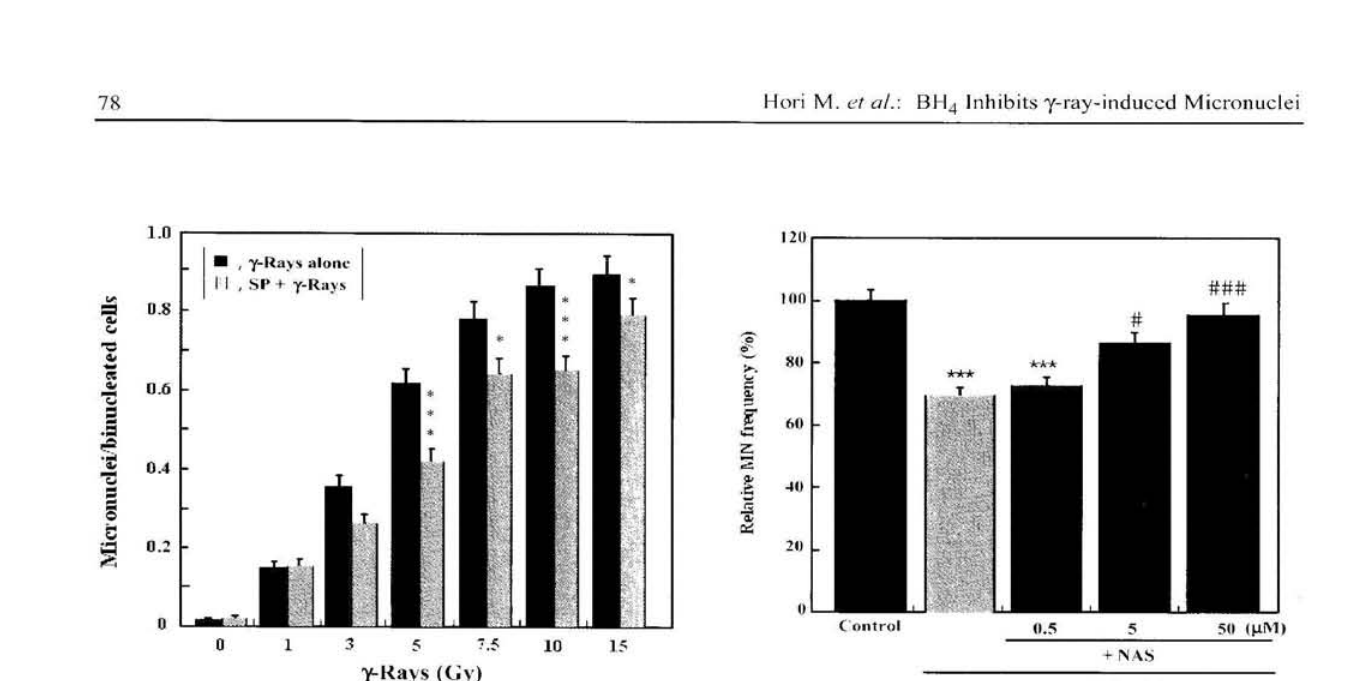
Figure 4. Micronucleus (MN) frequency induced by various doses of γ-rays at 18 h after treatment with 1 mM sepiapterin (SP) in RAW264.7 cells. RAW264.7 cells were incubated with 1 mM sepiapterin before irradiation with various doses of γ-rays. After exposure to γ-rays, the cells were kept for 24 h under growth conditions before the quantification of micronuclei. In each experiment, 500 binucleated cells were scorcd for micronuclei. Each point indicates the mean ± SE. *and ***, significantly different from the radiation-alone group at p<0.05 and p<0.005, respectively.